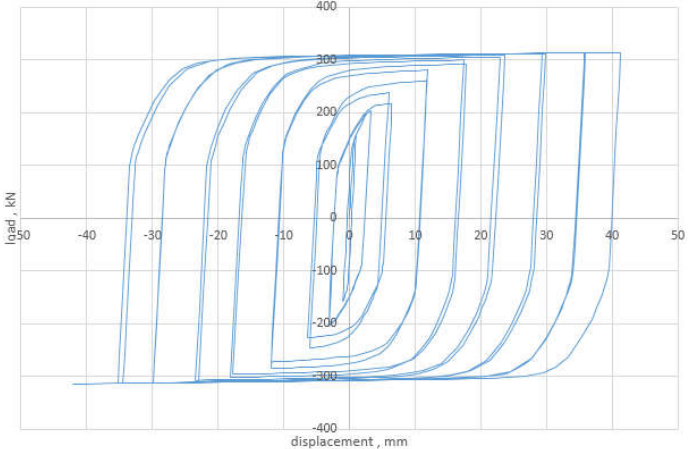
Figure 23. The hysteresis diagram resulting from the analysis of this sample in cyclic loading.